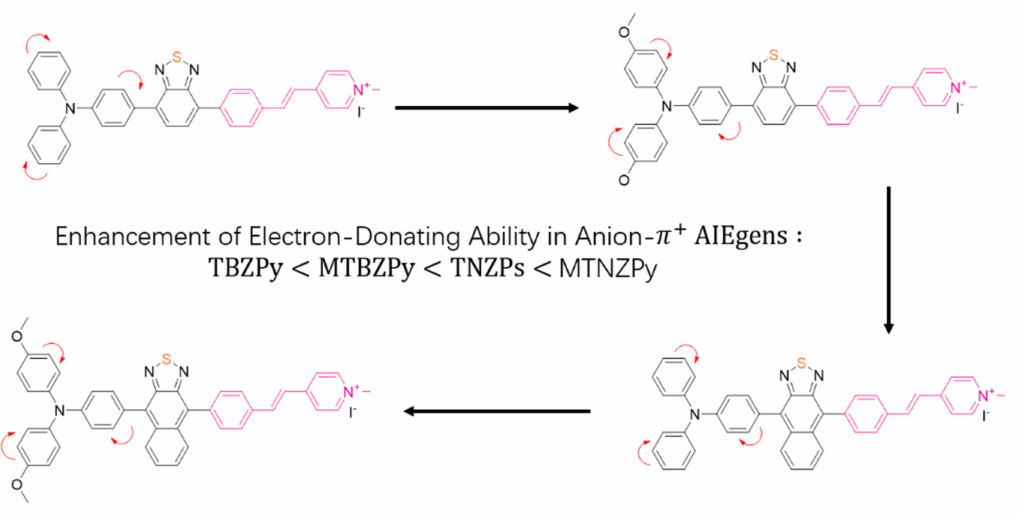
Figure 6. Chemical structures of the final products (TBZPy, MTBZPy, TNZPy, and MTNZPy). Adapted with permission from [106]. Copyright 2020 John Wiley and